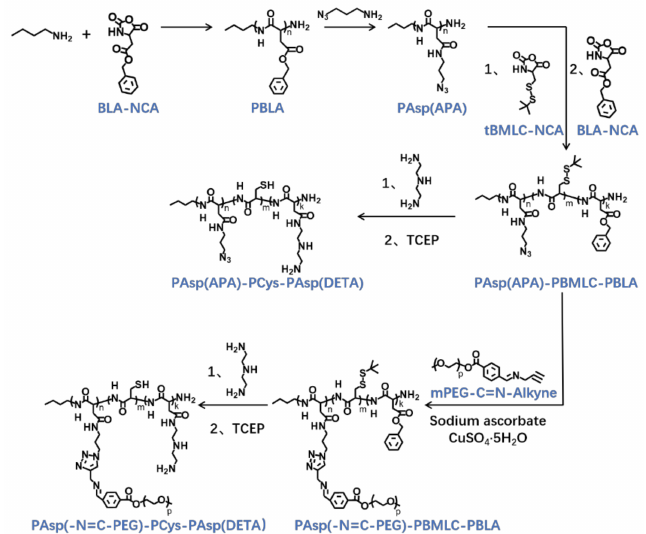
Figure 2. Synthetic route of PAsp(-N=C-PEG)-PCys-PAsp(DETA) and